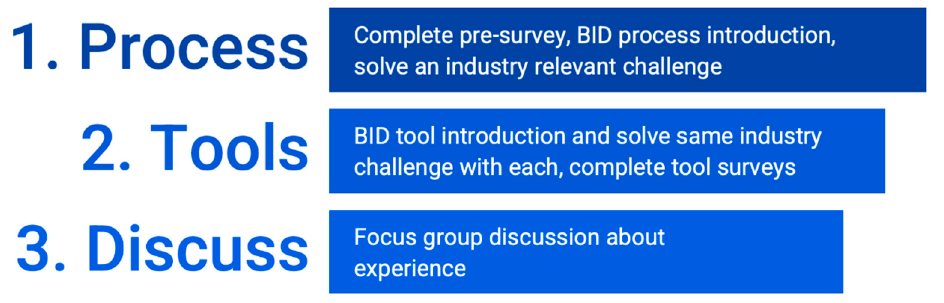
Figure 2. Training Overview.